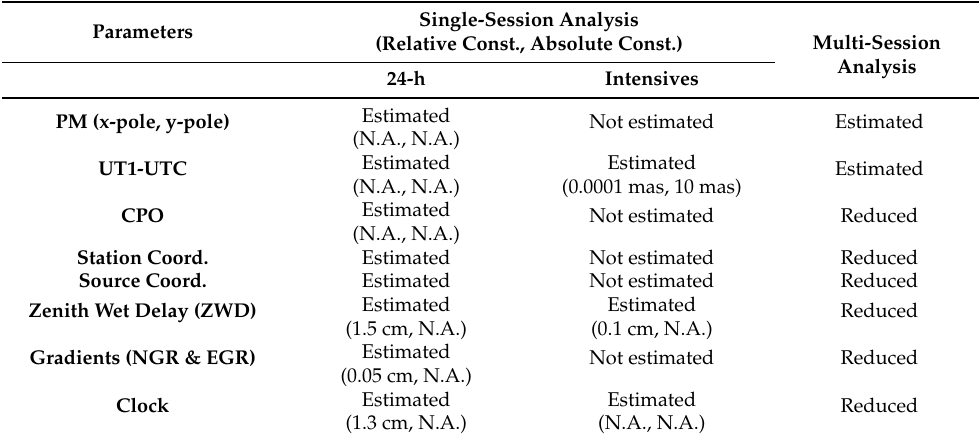
Table 4. Standard parameterization used for analyzing Intensive and 24 h VLBI sessions (constraints are given in brackets, if applicable; N.A. = not